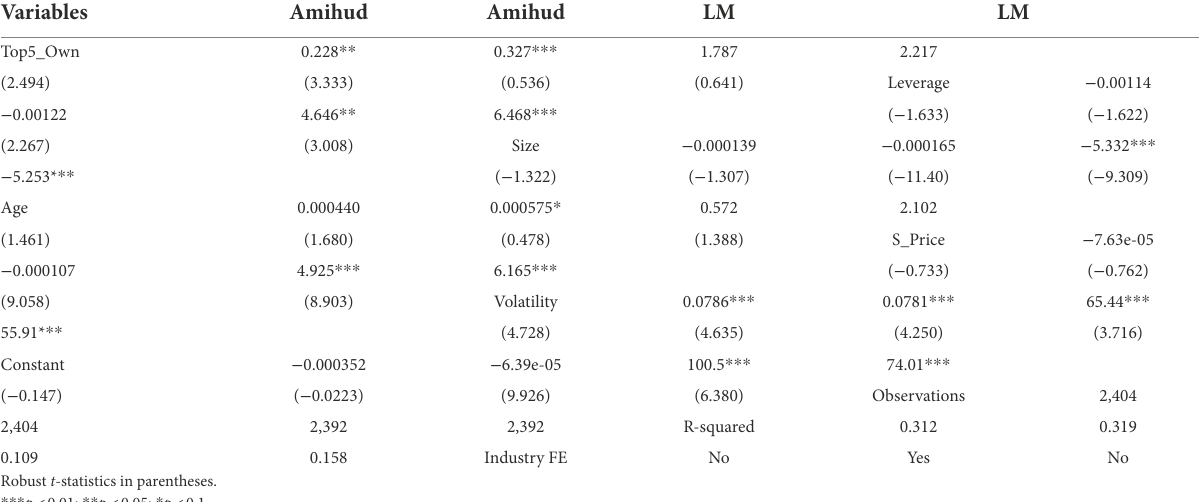
TABLE 8 Ownership concentration and Stock liquidity (OLS Regression).